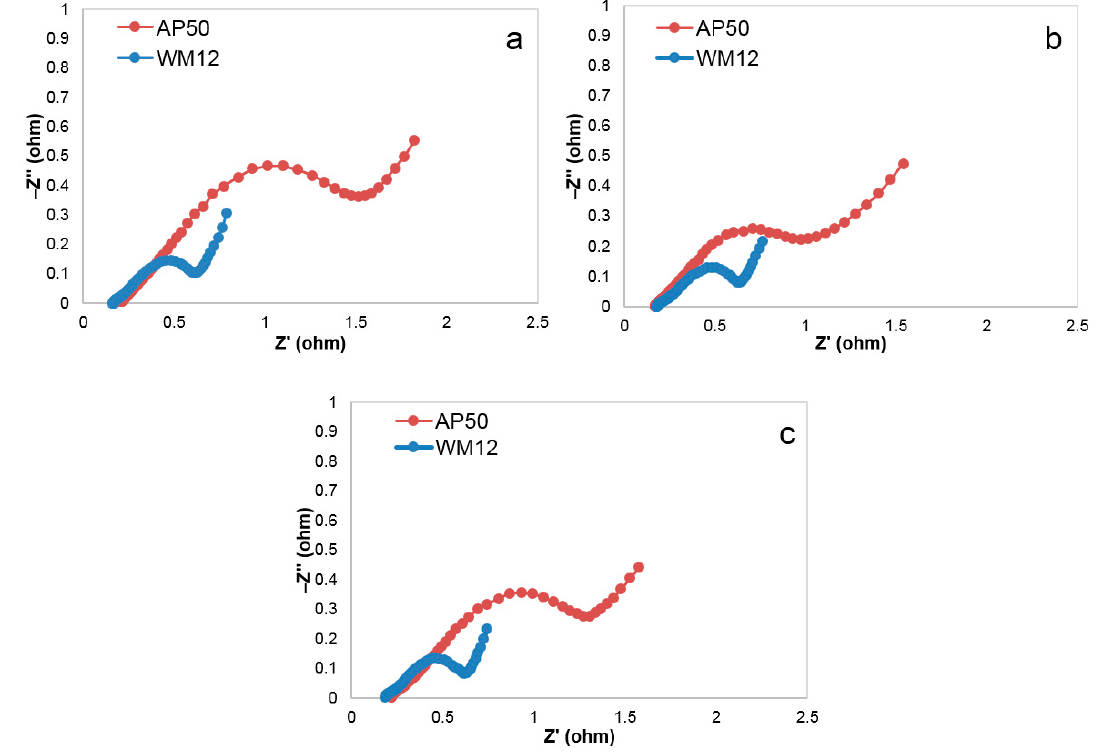
Figure 9. − 10 °C Cole-Cole plots for Cell AP50 and Cell WM12 at the ( a ) 0th, ( b ) 20th, and ( c ) 50th cycles obtained at 60% SOC.